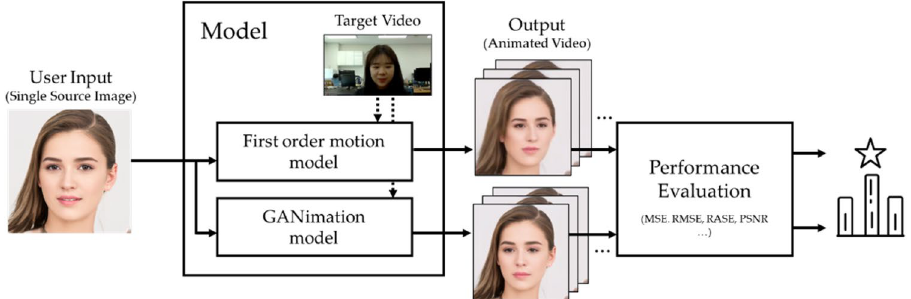
Figure 2. Framework for performance evaluation of animating-based expression swap.